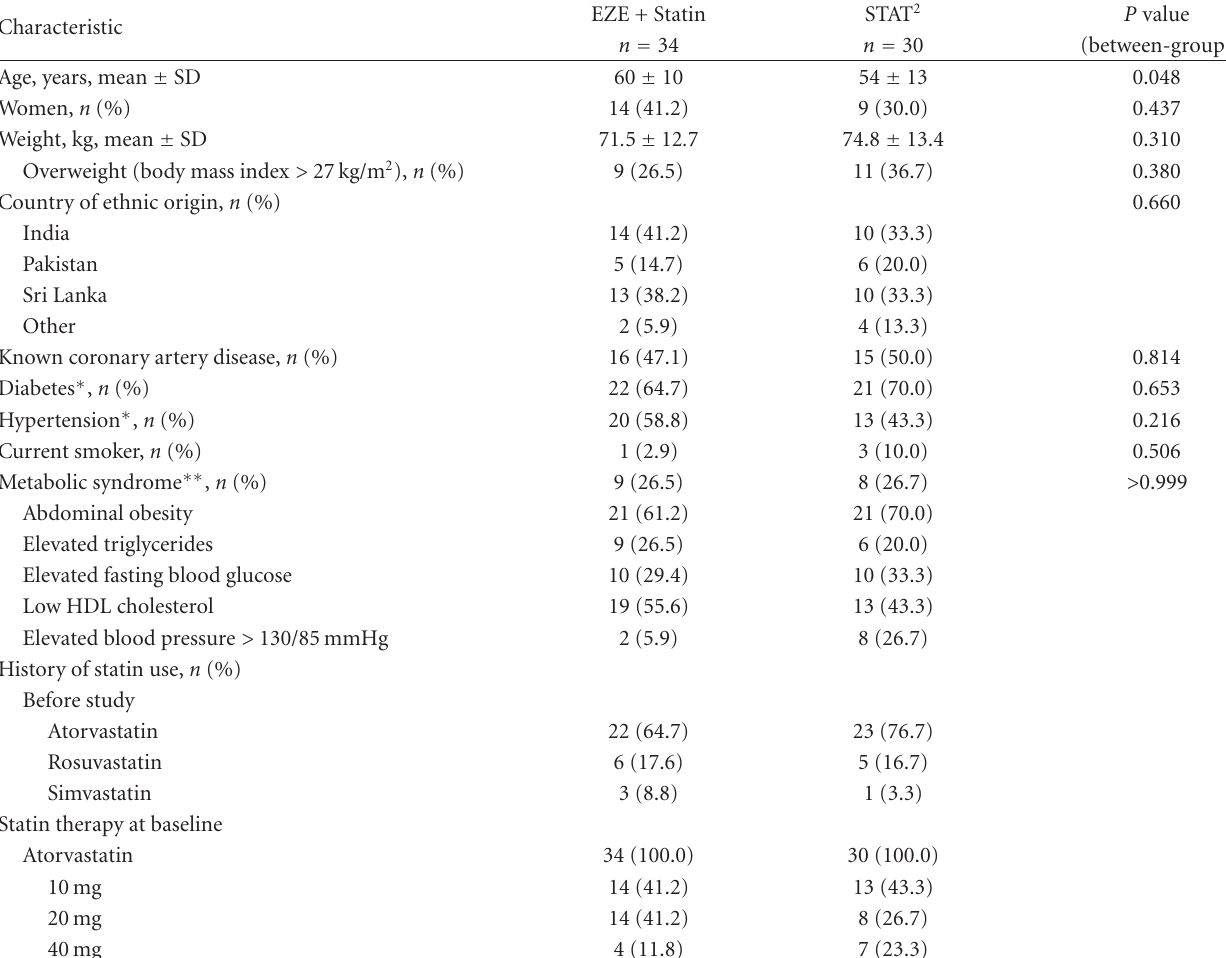
Table 1: Baseline